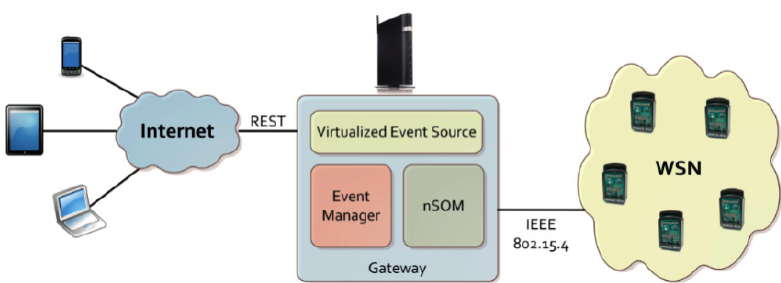
Figure 1. Virtualization model